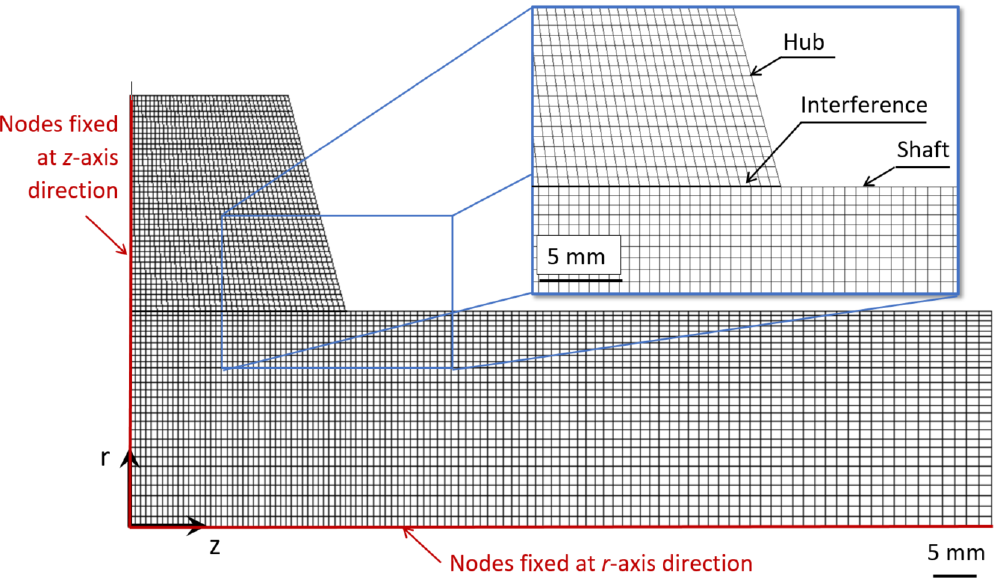
Figure 5. Mesh used in FEM simulations: general view showing the applied boundary conditions and the detailed view at the hub edge where stress concentration appears at the contact of the hub–shaft interface.